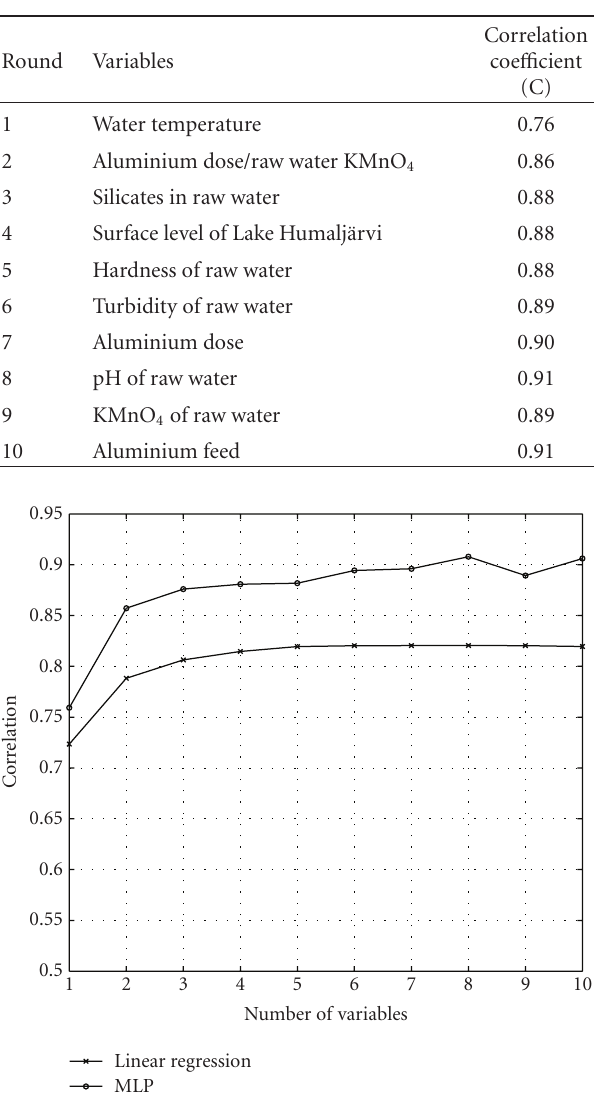
Table 6: Variables selected for residual aluminium using multilayer perceptrons (MLPs).